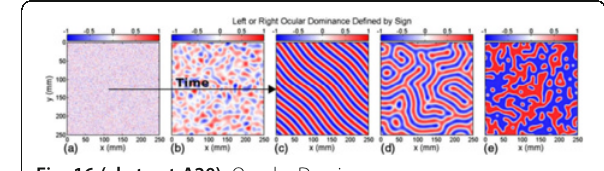
Fig. 16 (abstract A20). Occular